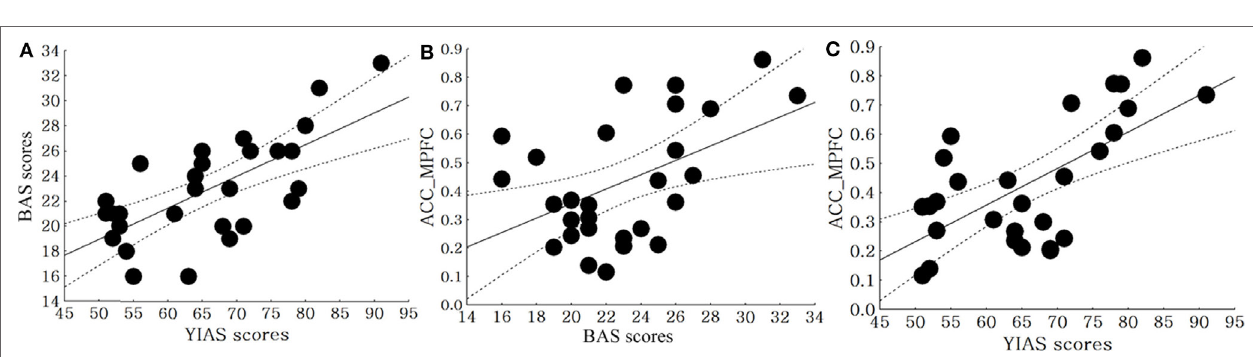
FigUre 3 | Correlation between clinical scales and brain connectivity in the SS allele and SL + LL allele groups. (a) Correlation between the BAS and Young Internet Addiction Scale (YIAS) scores in the SS allele group ( r = 0.68, p < 0.01), (B) correlation between the BIS scores and FC from anterior cingulate cortex (ACC) to middle prefrontal cortex (MPFC) in SS allele group ( r = 0.48, p = 0.01), (c) correlation between the YIAS scores and FC from ACC to MPFC in SS allele group ( r = 0.64, p < 0.01).